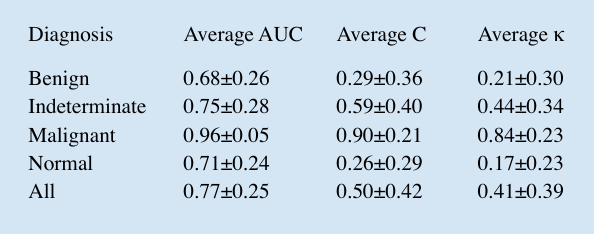
Table III. Average of the best matching results for MI- matching